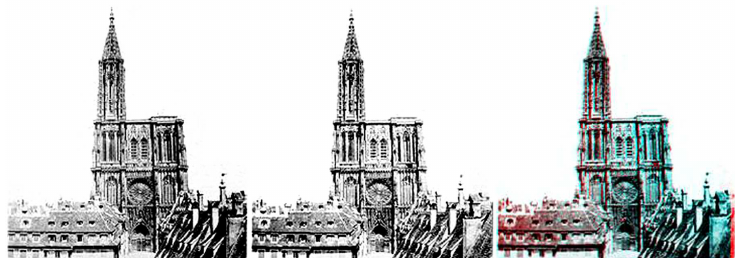
Figure 1. As homage to the XXIVth international CIPA Symposium in Strasbourg, a historic stereo view of the famous Strasbourg Cathedral, dated approximately 1860 is shown beside the 3D color anaglyphs presentation (use color anaglyph glasses, repro photography by W.